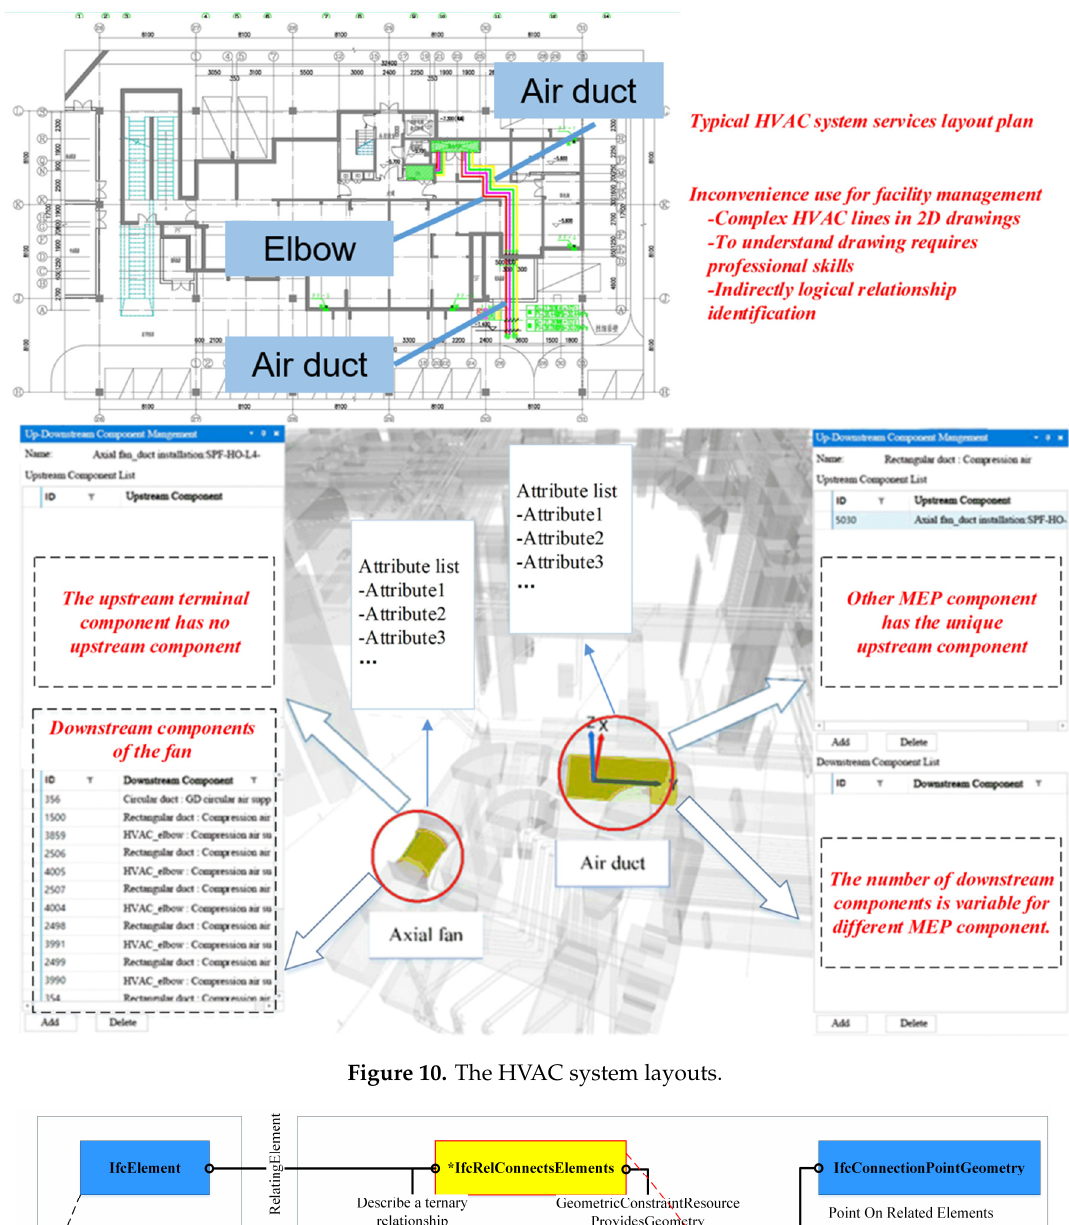
Figure 10. The HVAC system layouts.